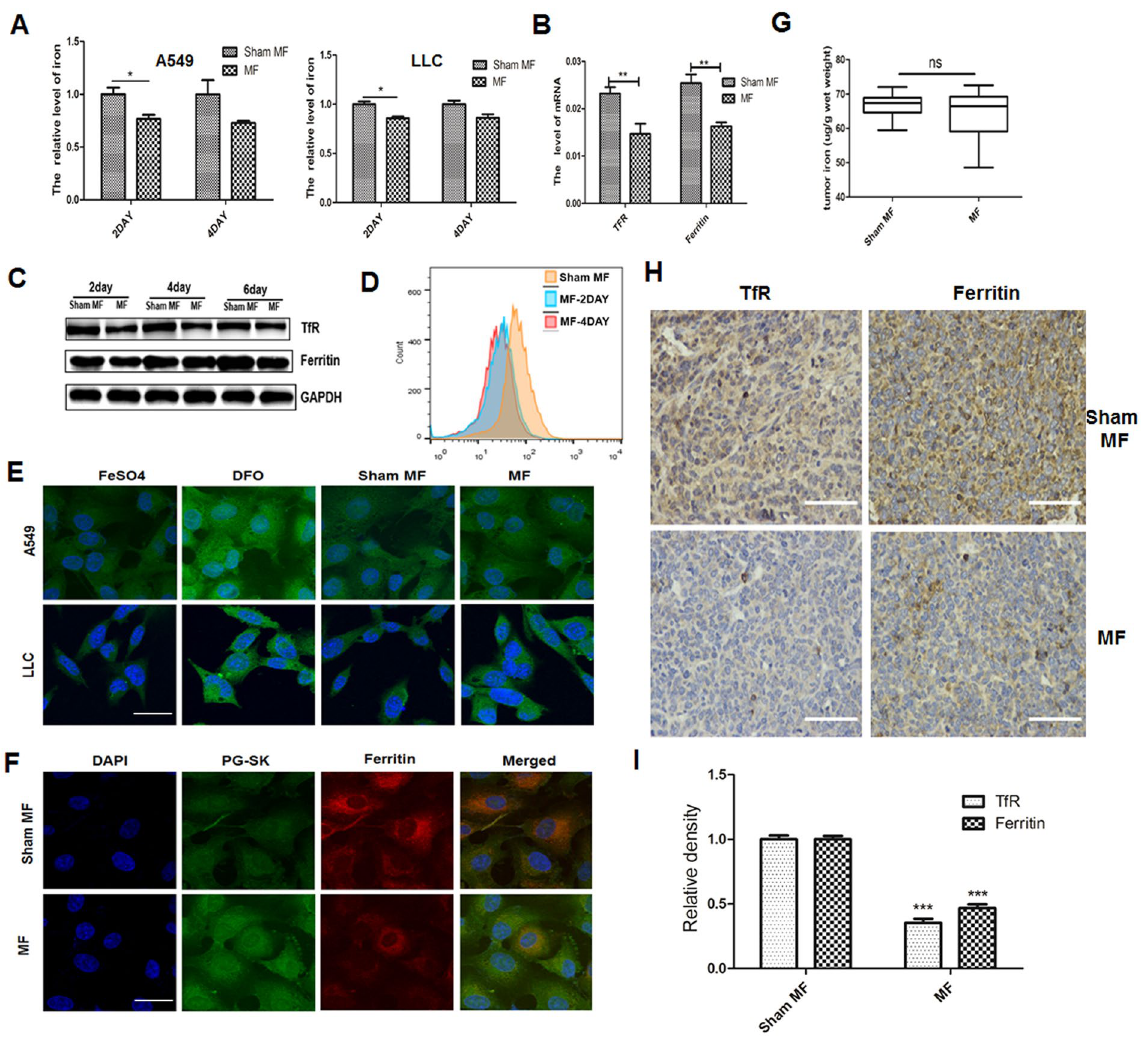
Figure 6. Low frequency magnetic fields induce lung cancer cell iron metabolism dysfunction. A549 and LLC cells were treated with MF or Sham MF for 2–4 days. ( A ) Cells were washed, digested with 5% HNO3 and the supernatant collected for intracellular non-haem iron estimation using flame atomic absorption spectrometer. ( B ) The mRNA levels of TfR and ferritin in LLC cells were detected using Q-PCR. ( C ) Protein level of TfR and ferritin in LLC cells were detected using western blot. Numbers under each blot are relative intensity of the blot. ( D ) Surface expression of TfR on LLC cells was detected using flow cytometry. ( E ) Immunofluorescence analysis of A549 and LLC cells treated with MF or Sham MF for 2days. Fluorescent probe Phen Green SK (PG-SK) was used for monitoring labile iron pool (Green). Cells treated with 100 μ M ferrous sulfate (FeSO4) for 10 min were taken as positive control. Cells incubated with 100 μ M DFO for 15 min were taken as negative control. Scale bars, 20 µ m. ( F ) Immunofluorescence analysis of A549 cells treated by MF or Sham MF for 2 days. The cells were fixed and stained with ferritin antibody (red), PG-SK (Green), and DAPI (blue) respectively. Scale bars, 20 µ m. ( G ) Measurement of non-haem iron content in tumor tissue of LLC murine model. (n = 6) ( H ) Immunochemistry analyzes TfR and ferritin-H expression in tumor tissue of LLC murine model. (n = 6); Scale bars, 100 µ m. ( I) IHC images were calculated using Image Pro Plus software 6.0. All experiments were repeated three times. Data represent Mean ± SEM. * P < 0.05, ** P < 0.01, *** P <